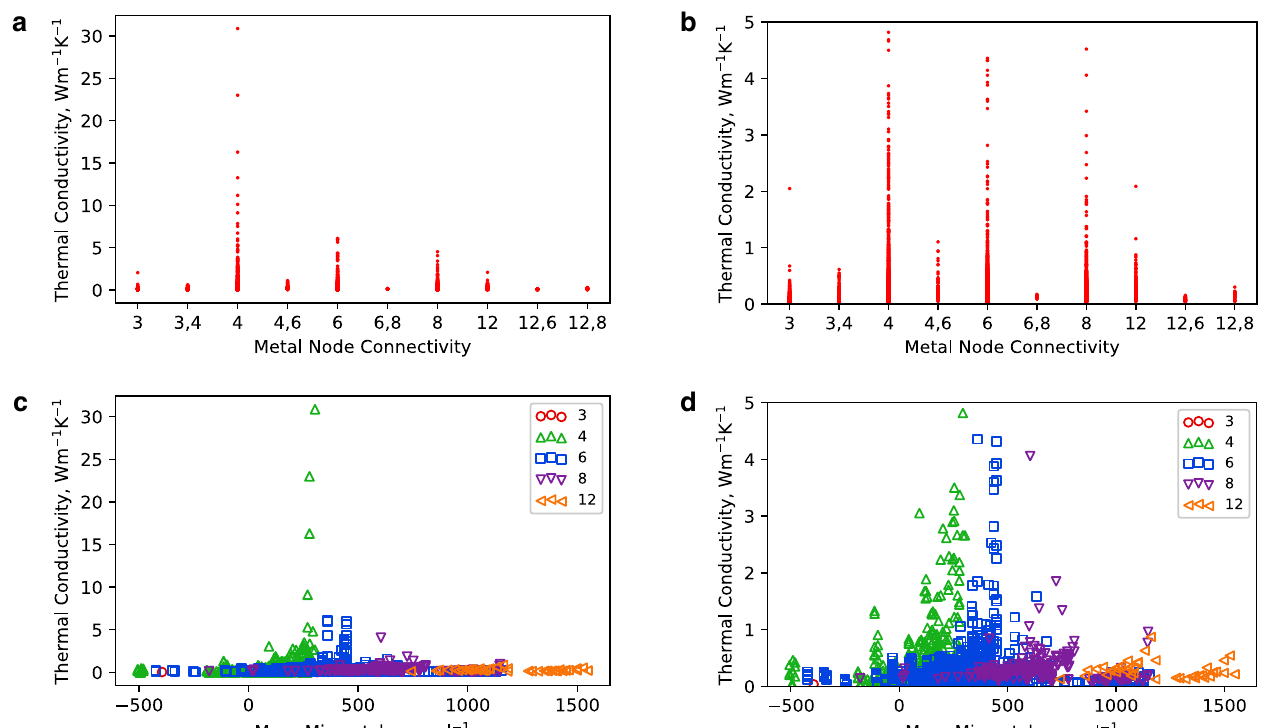
Fig. 6 Thermal conductivity and compositional/geometric characteristics. Relationships of the average thermal conductivity with metal node connectivity ( a , b ) and node-linker mass mismatch ( c , d ). The fi gures ( a , b ) and ( c , d ) are the same plots but with a different vertical scale. In fi gures ( a , b ), the pairs of numbers (e.g., 3,4 and 12,6) mean two different types of metal node connectivity in a structure. Colors: red (3- connected), green (4-connected), blue (6-connected), purple (8-connected), and orange